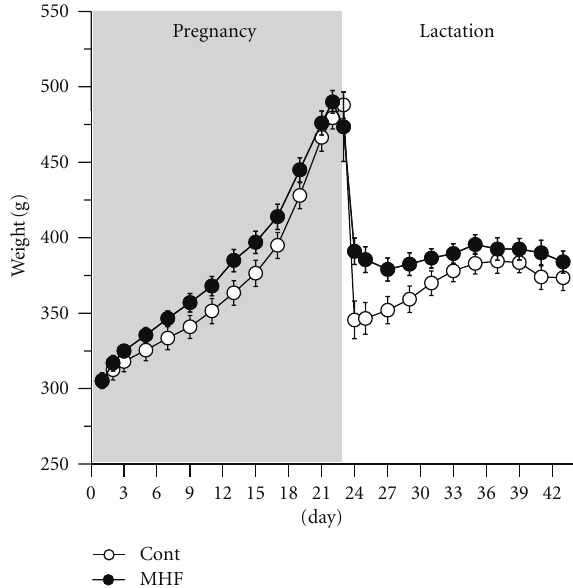
Figure 2: Maternal body weights during pregnancy and lactation. There was no overall significant e ff ect of neonatal LA administra- tion on weight of dams during pregnancy and lactation thus data for Sal and LA groups for each respective maternal diet have been combined. Data are means ± SEM with a minimum of 5 litters per